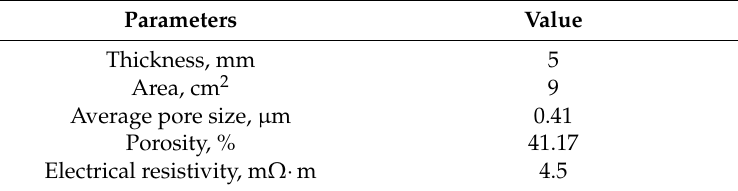
Table 1. Characteristics of nano-TiO 2 /carbon membrane.